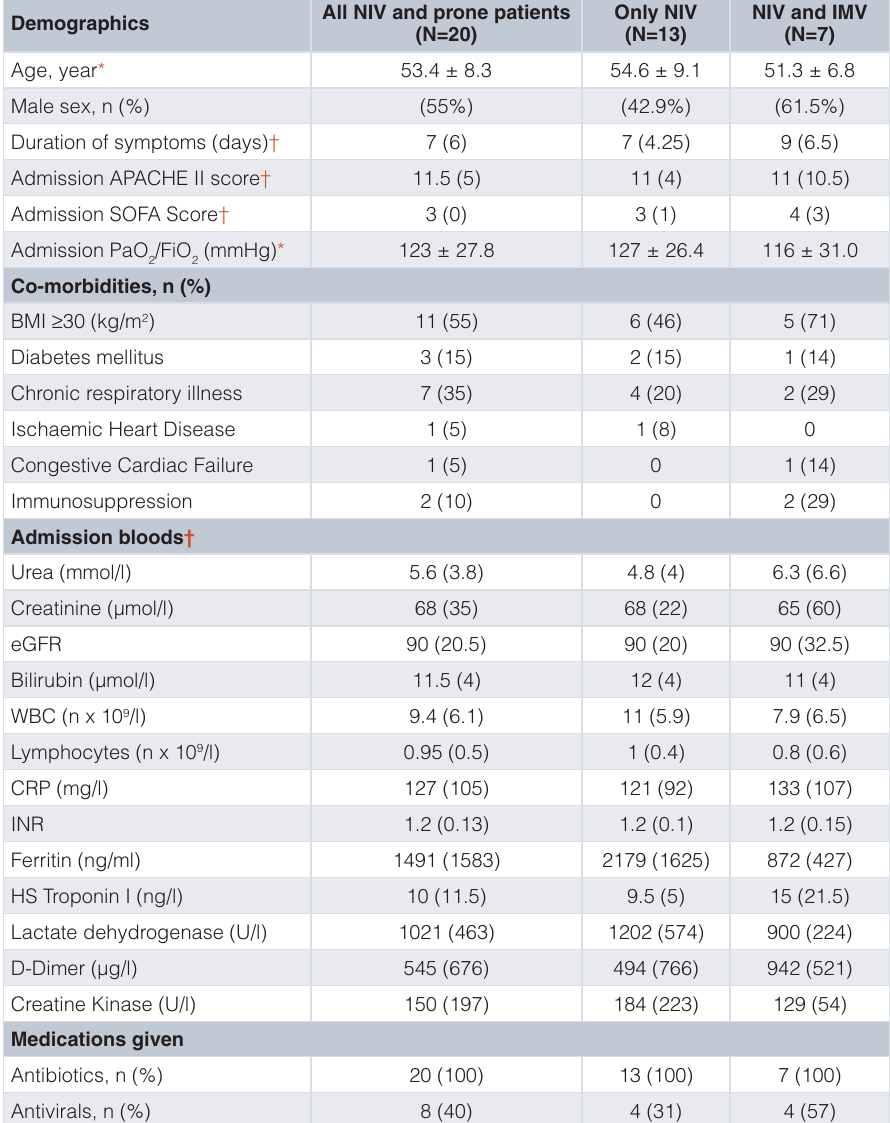
Table 1. Patient demographics for all patients admitted and received non-invasive ventilation and self-prone positioning.